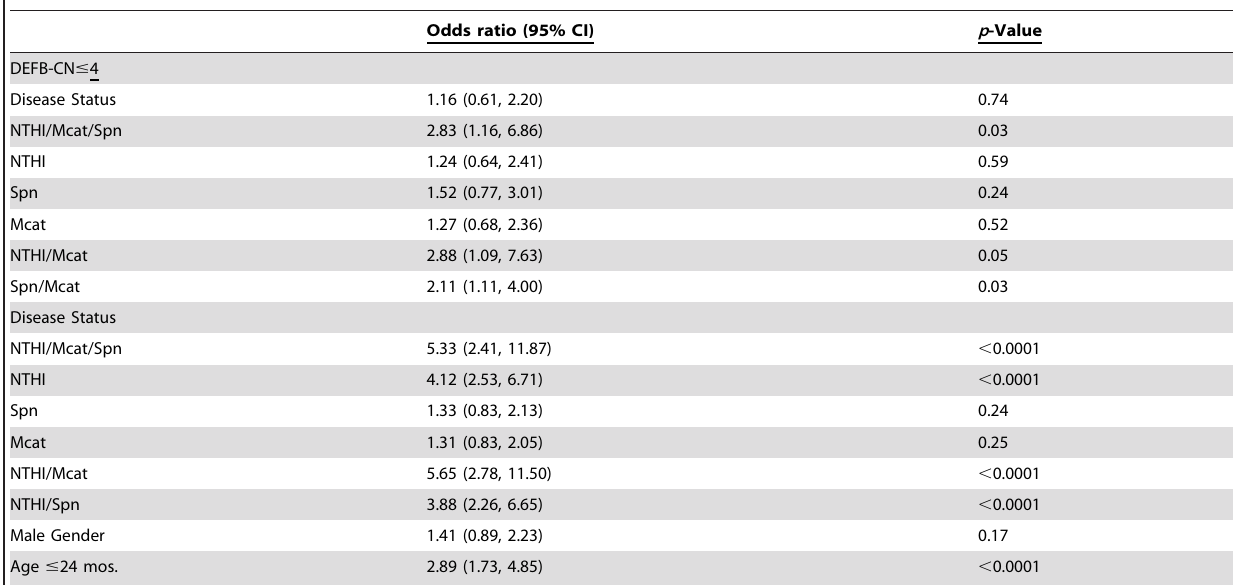
Table 3. Univariate analyses of subject-level